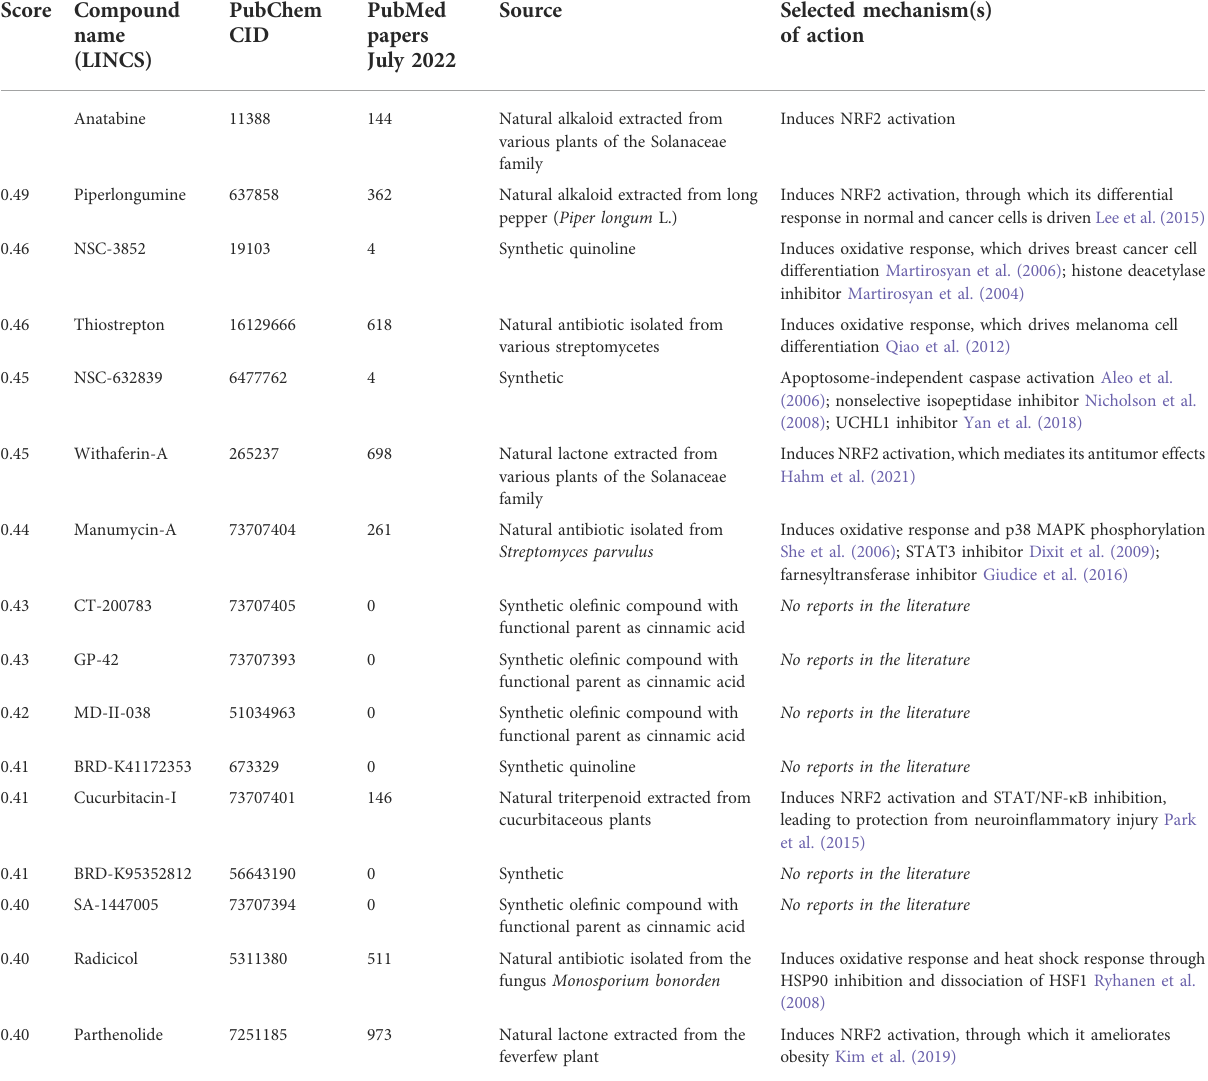
TABLE 1 Compounds in the LINCS L1000 dataset with the most similar transcriptomic response to